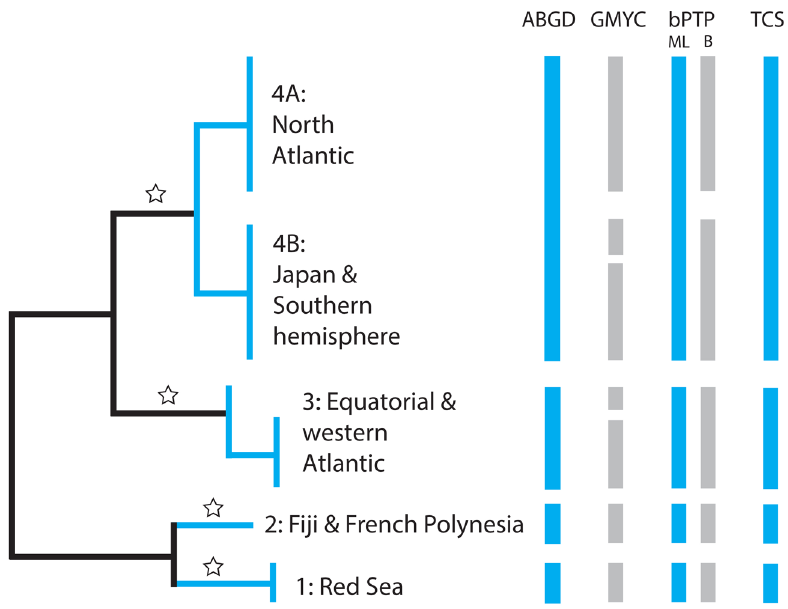
Figure 5. Overview of groupings resulting from the various species delimitation methods applied to COI data. A representative, simplified topology (combined COI + ITS-2) is shown; the four strongly supported clades are indicated with a star and basic geographical ranges of clades are indicated. Vertical bars indicate putative species groups for each method. Groupings from GMYC are shown for Yule and coalescent models with a constant clock. Results for bPTP from Maximum Likelihood (ML) and Bayesian (B) partitions are